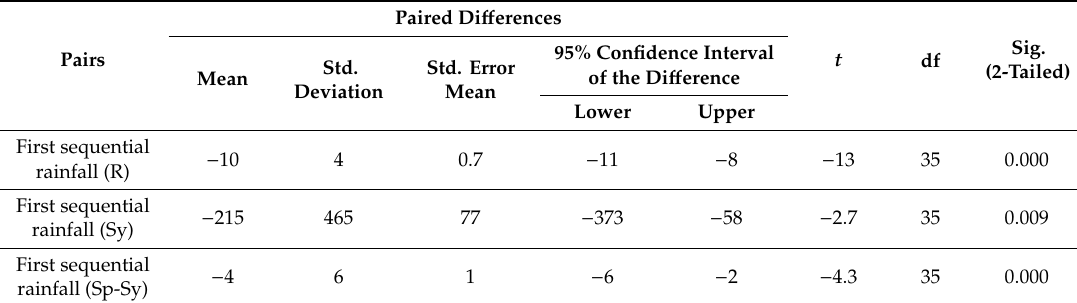
Table 7. Comparison of first and sequential rainfalls with the dependent sample t -test for Tr, Sy, and